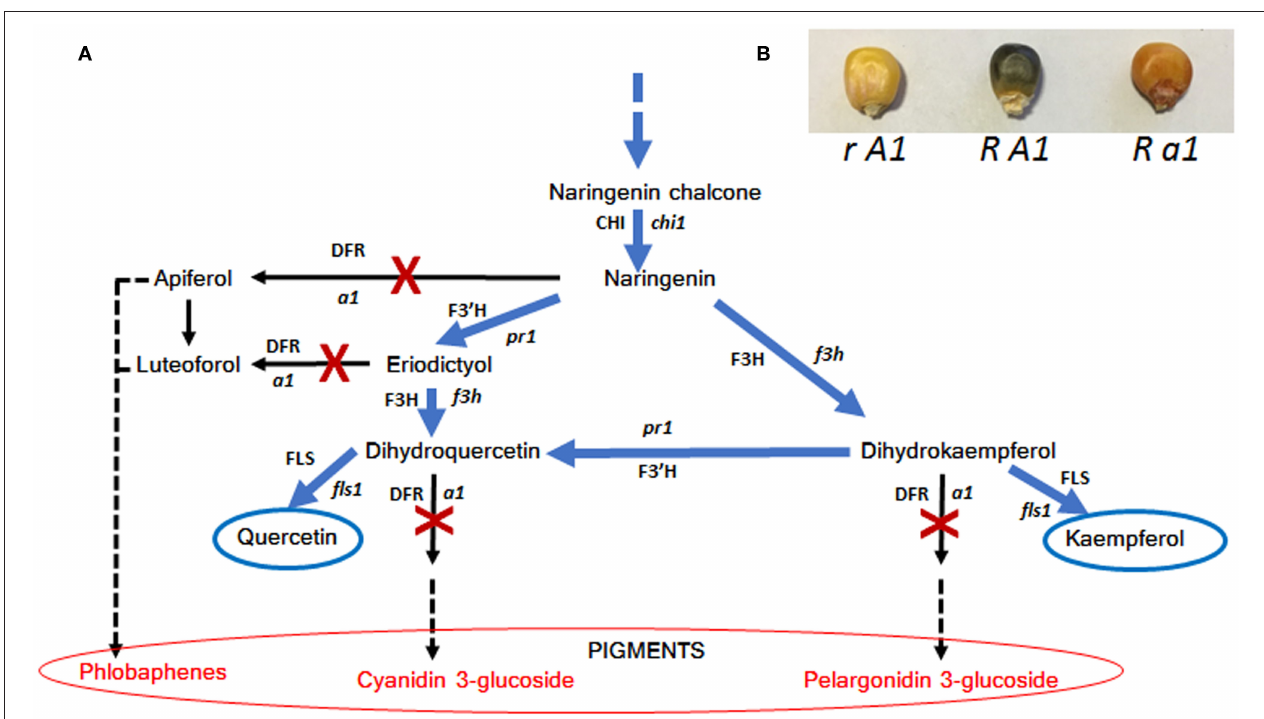
FIGURE 3 | Schematic representation of how plants accumulate quercetin and kaempferol by stopping the activity of DFR (A) and (B) effect of a1 (DFR) mutation on maize seed pigmentation. Genes (enzymes) are abbreviated as follows: c2 (CHS), chalcone synthase; chi1 (CHI), chalcone isomerase; f3h (F3H), flavanone 3-hydroxylase; pr1 (F3 ′ H), flavonone 3 ′ -hydroxylase; a1 (DFR), dihydroflavonol synthase. In (B) R represent red color 1, a regulatory gene conferring anthocyanin pigmentation in the aleurone seed